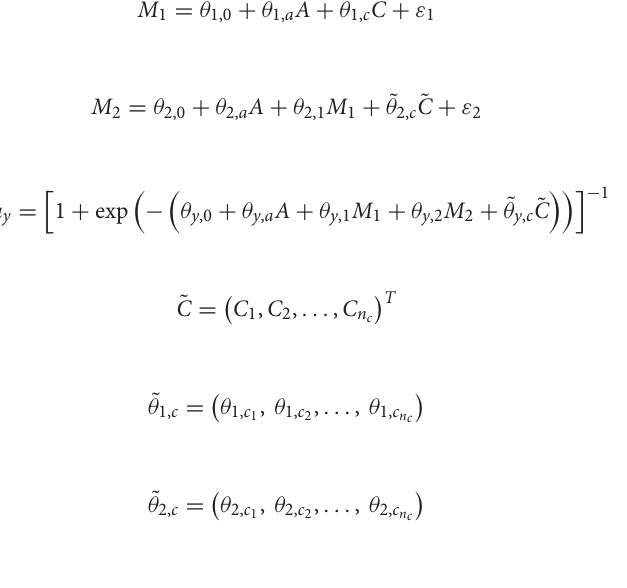
the g-computation algorithm approximation estimation of Q ( a 1 , a 2 , a 3 , a 4 , ) . Based on formulae (5), we can obtain the point estimations of iTE and the four iPSEs in the OR